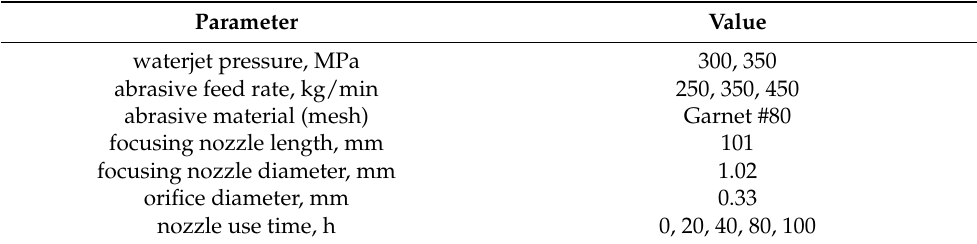
Table 1. Experimental conditions.